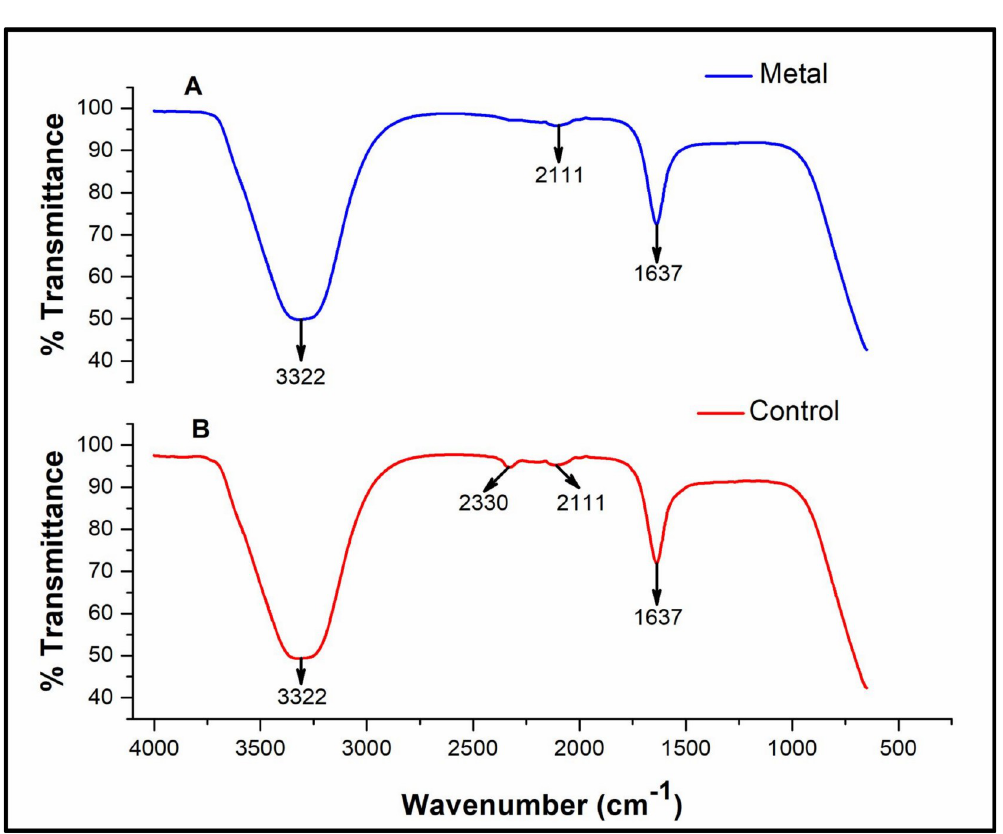
Fig 8. IR Spectroscopy of AgNPs synthesized extracellularly by the Ag0.5–5 Fusarium scirpi strain. IR spectra of AgNPs formed in the water-filtrate of Fusarium scirpi cultures ( blue lines ). The IR absorption of the fungal filtrate without the addition of AgNO 3 was analyzed as controls ( red lines